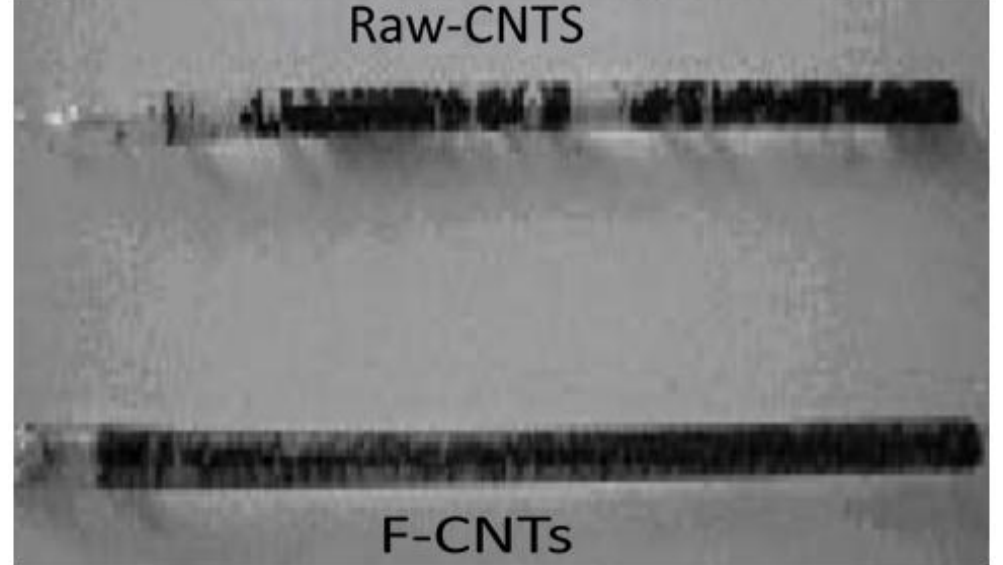
Fig. 2: Carbon nanotubes before and after